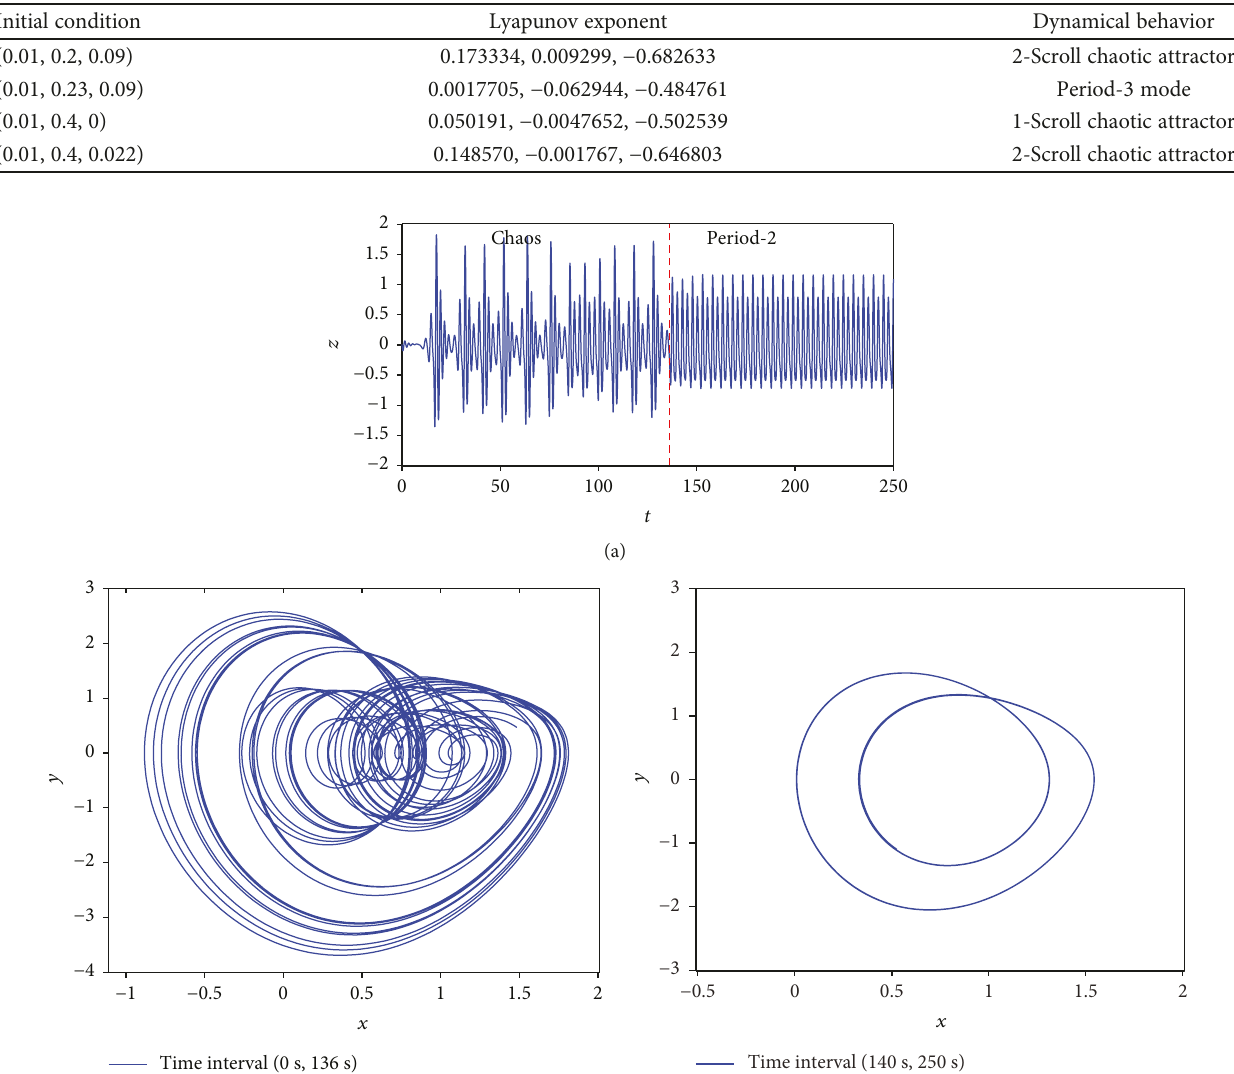
Table 1: Multistable behavior of system (4) with a = 0 5 , b = 0 8 , c = 0 6 , d = 3 , and k = 0 95 .